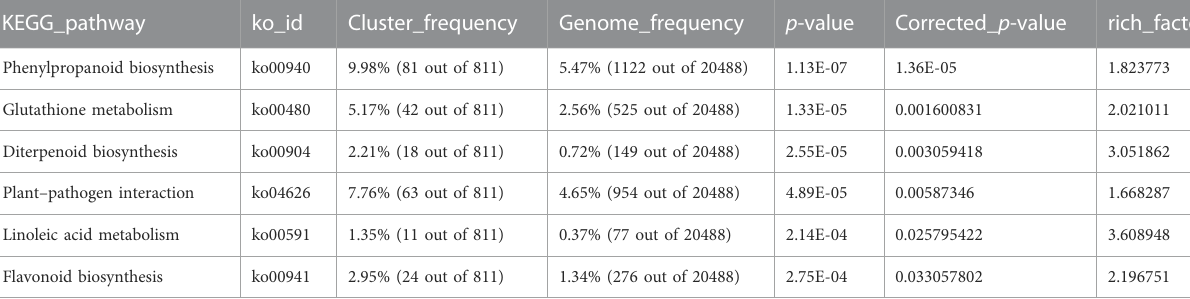
TABLE 2 KEGG enrichment analysis of 5,504 DEGs in root tissue at 6 h after salt stress.